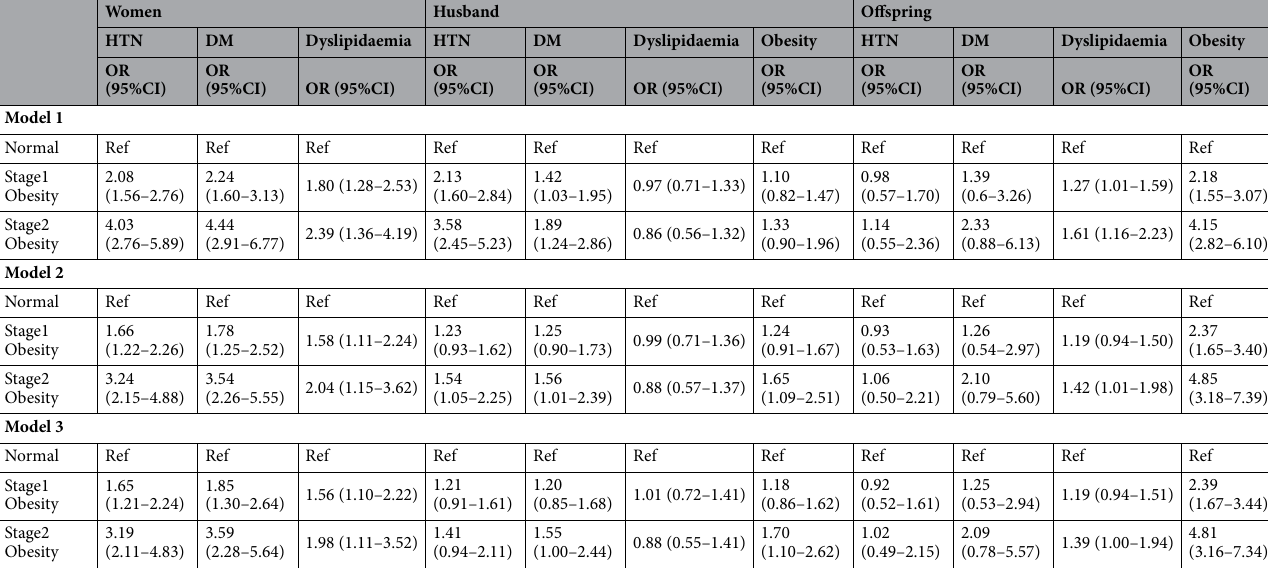
Table 2. Association of women’s trajectories of BMI with the whole family outcomes. Model 1: unadjusted OR (95% CI). Model 2: adjusted for age, education, employment, and marital status. Model 3: adjusted for age, education, employment, marital status, smoking, and physical activity. *In offspring, Model 2 and 3 are adjusted for sex in addition to the covariates mentioned